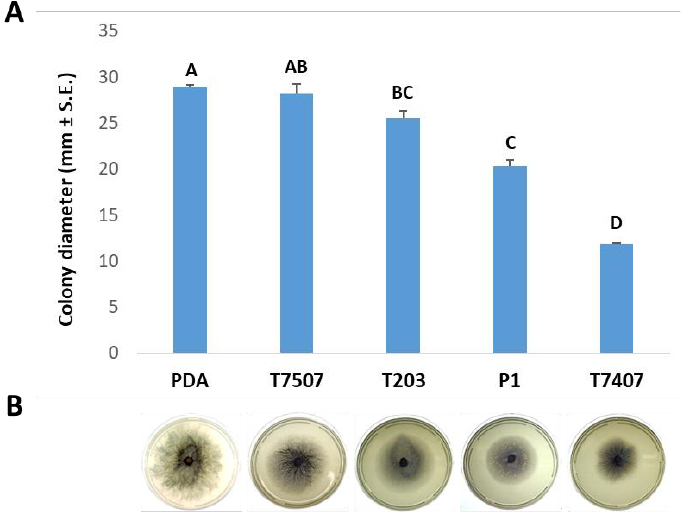
Figure 2. Effect of Trichoderma spp.-secreted metabolites on M. maydis solid media cultures. Trichoderma species tested are listed in Figure 1. The Trichoderma cultures’ filtrate was used to prepare potato dextrose agar (PDA) plates (instead of DDW). The plate was sown with M. maydis and incubated for six days. Control is PDA medium M. maydis cultures maintained under the same conditions. ( A ) Values are means from five biological replicates ± standard error. Different letters (A–D) indicate significant differences (one-way ANOVA test, p < 0.05). ( B ) Representative Petri dishes photograph of each treatment at the experiment’s end.